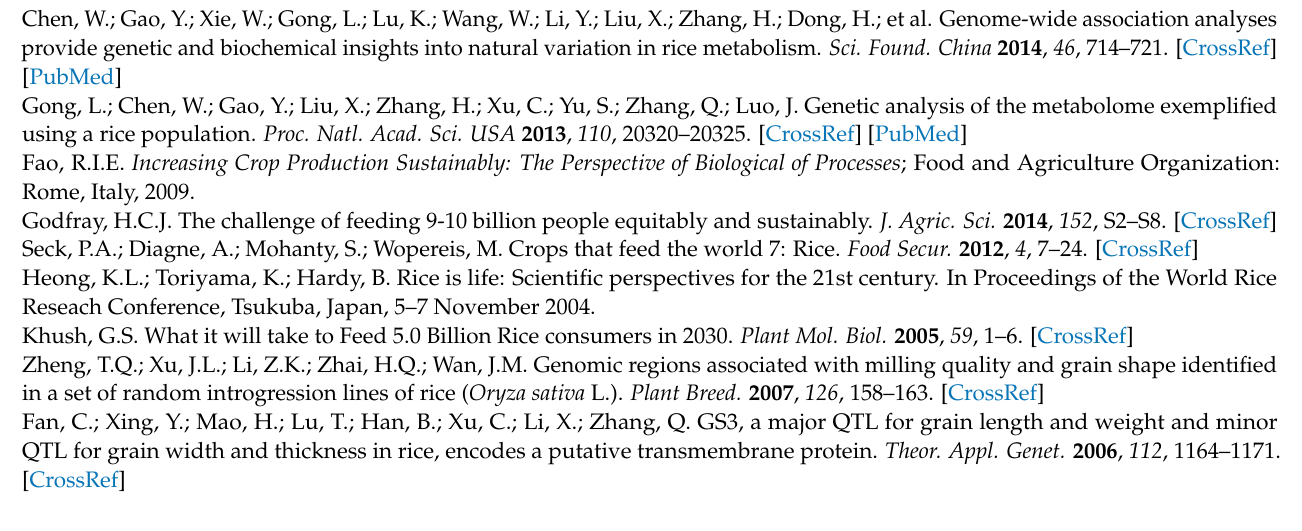
Table S1: Information of 137 rice accessions. Figure S2: LD decay distance estimated for 220 rice accessions. Table S2: Analysis of variance associated with grain weight, grain shape and chalkiness traits. Figure S3: Distribution of single nucleotide polymorphisms (SNPs) and nucleotide diversity across the rice Nipponbare genome in the rice association panel. Table S3: BLUP values consis- tently determined QTN of grain weight, grain shape and chalkiness traits by TASSEL in the three environments. Table S4: List of genes associated with grain weight, grain shape and chalkiness